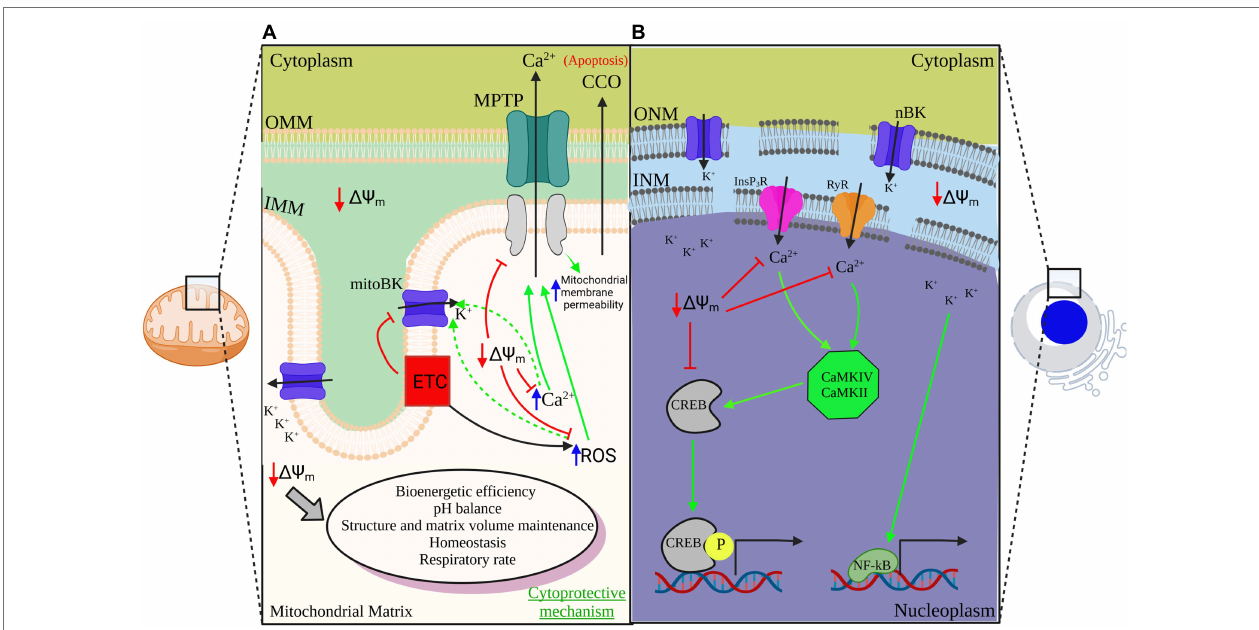
FIGURE 1 | Proposed scheme for the functional role of the BK channel in double-membrane organelles. (A) Mitochondria, (B) Nucleus. In both organelles, BK plays a fundamental role in maintaining the transmembrane potential and in regulating the movement of the calcium ion between the cytosol and the organelle, and between the lumen and the internal membrane of the same. MitoBK is involved in mitochondrial function, structure, homeostasis, and volume, as well as pH control, bioenergetic efficiency, respiratory rate (through a structural and functional assembly with the chain electron transporter (ETC)), in the closure of the mitochondrial permeability transition pore (MPTP) and with it, indirectly, in the release of cytochrome C oxidase (CCO). Thus, it would ultimately be involved in apoptosis and death cells. nBK is involved in pCREB-dependent gene regulation (in principle regulated by Calmodulin-dependent kinases (CaMKIV and CaMKII)) and NF-kB, mechanisms by which, to date, nBK has been associated with neuronal survival and response inflammatory mediated by macrophages,